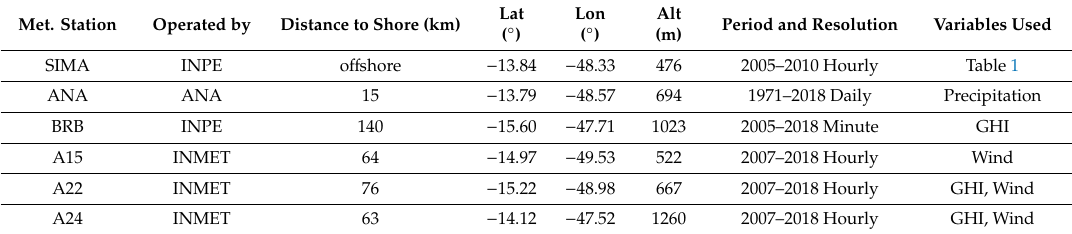
Table 2. Details of SIMA buoy system and ground measurement sites near the Serra da Mesa Reservoir used to estimate the climate-relevant variables for this